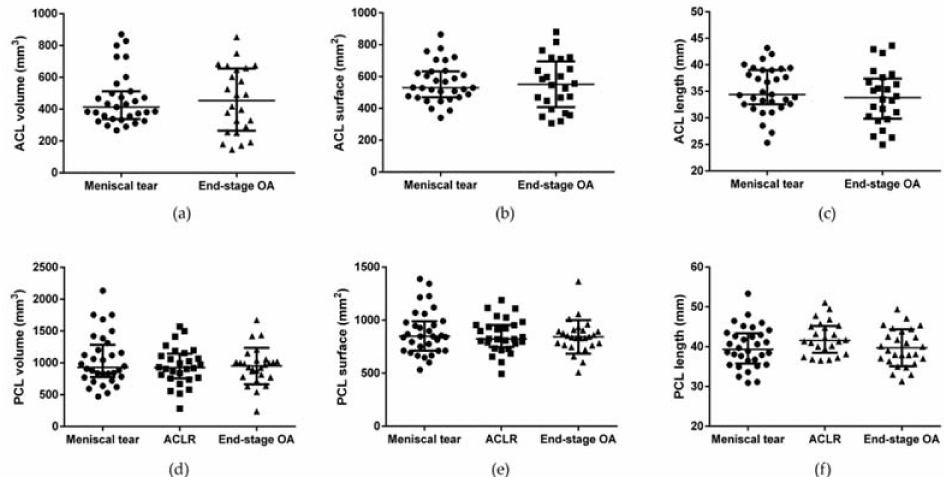
Figure 5. ACL and PCL morphometric characteristics in patients with meniscal tear, ACLR, and end-stage OA. ( a ) ACL volume, ( b ) ACL surface, ( c ) ACL length, ( d ) PCL volume, ( e ) PCL surface, and ( f ) PCL length. Data are expressed as median (interquartile range). ACL: anterior cruciate ligament. PCL: posterior cruciate ligament. ACLR: anterior ligament cruciate rupture. PL volume, surface, length, depth, and arc were measured in all the groups showing no differences with the only exception being PL depth (Figure 6, Table 4). PL depth was higher in patients with meniscal tear compared to end-stage OA patients ( p = 0.023).